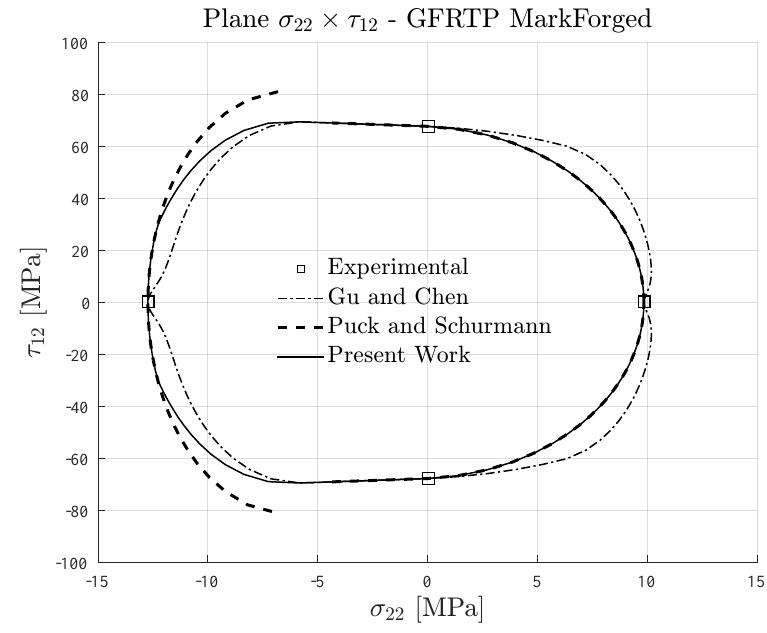
Figure 11. Failure envelopes on the stress space σ 22 × τ 12 for 3D-printed continuous glass-fiber reinforced thermoplastic lamina. Inclination parameter p c ⊥⊥ = 0.2 for Puck and Schürmann and Expanded Puck and